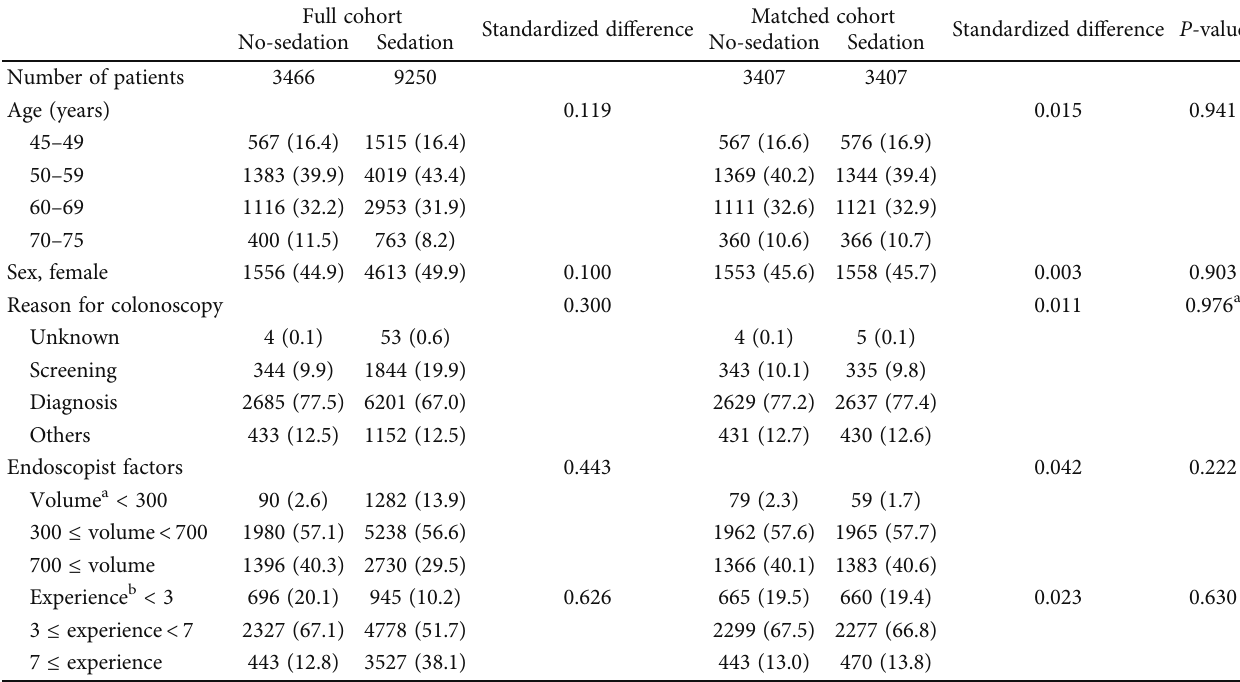
Table 5: Characteristics in the full cohort and propensity score-based matched